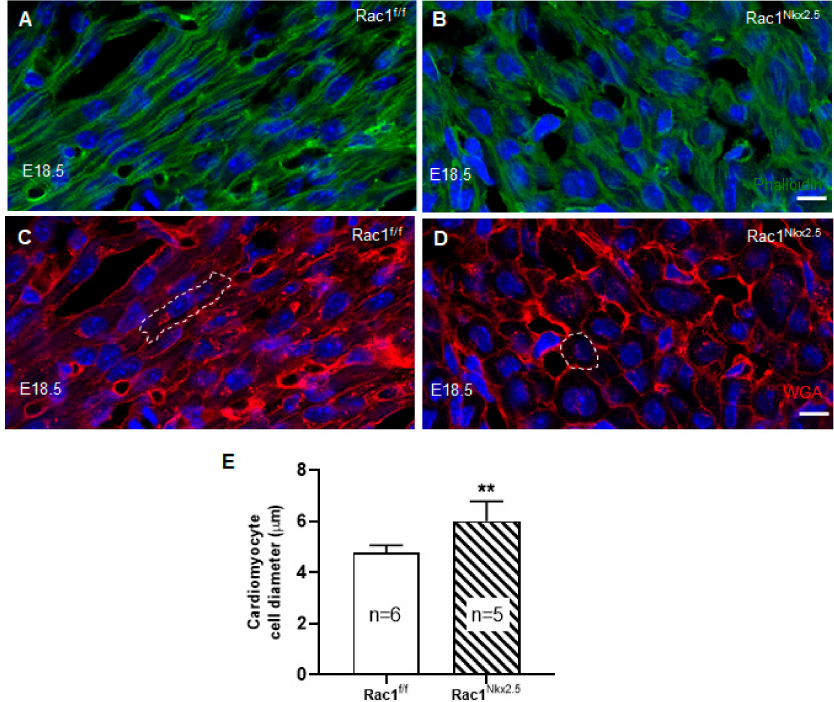
Figure 5. Disruption of F-actin organization and cardiomyocyte polarity in Rac1 Nkx2.5 hearts. E18.5 cryosections of the heart were double stained for phalloidin and wheat germ agglutinin (WGA) to assess F-actin organization and cardiomyocyte cell polarity, respectively. The images were taken from the corresponding areas of LV myocardium free wall in Rac1 f/f and Rac1 Nkx2.5 mice. F-actin filament organization was disrupted in Rac1 Nkx2.5 myocardium ( B ) compared to littermate controls ( A ). WGA staining shows rounded cardiomyocytes in Rac1 Nkx2.5 ventricular myocardium ( D ) compared to the elongated cardiomyocytes in littermate controls ( C ). The cell borders of a cardiomyocyte in ( C , D ) are outlined. The short axis of cardiomyocyte diameter was significantly larger in Rac1 Nkx2.5